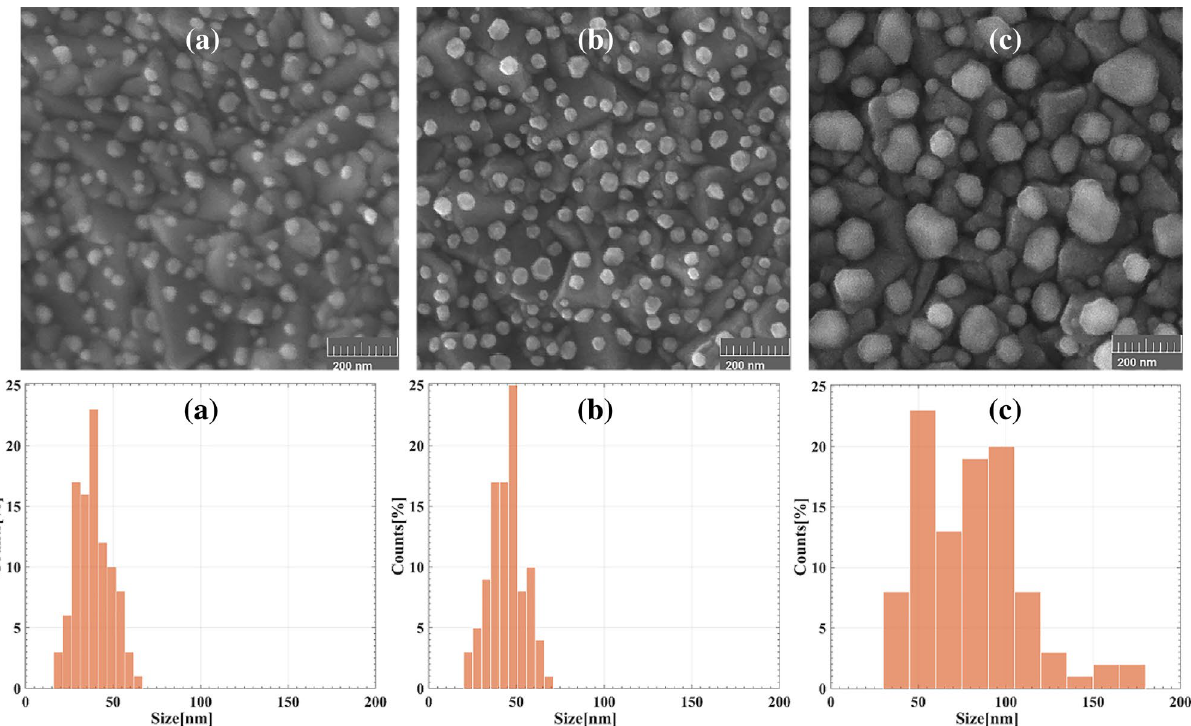
Figure 2. SEM images and size distribution histograms of Au nanocores fabricated by thermal annealing of Au thin films with different deposition thicknesses of ( a ) 2.5 nm, ( b ) 5 nm and ( c ) 10